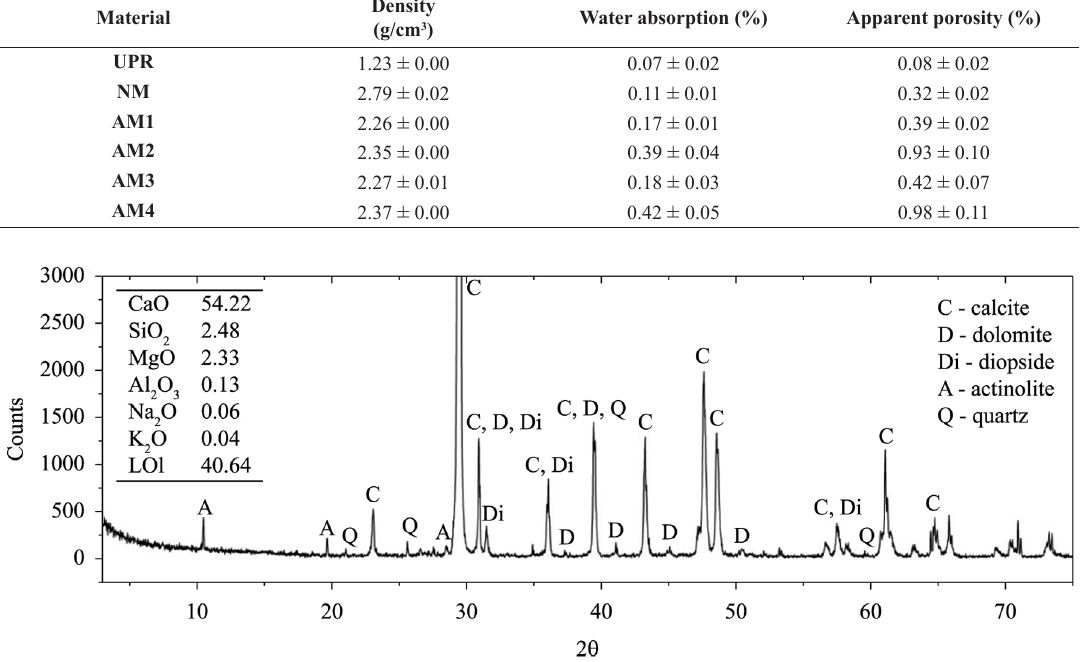
Figure 1. X-ray diffraction pattern and chemical composition (wt%) of the marble waste sample.